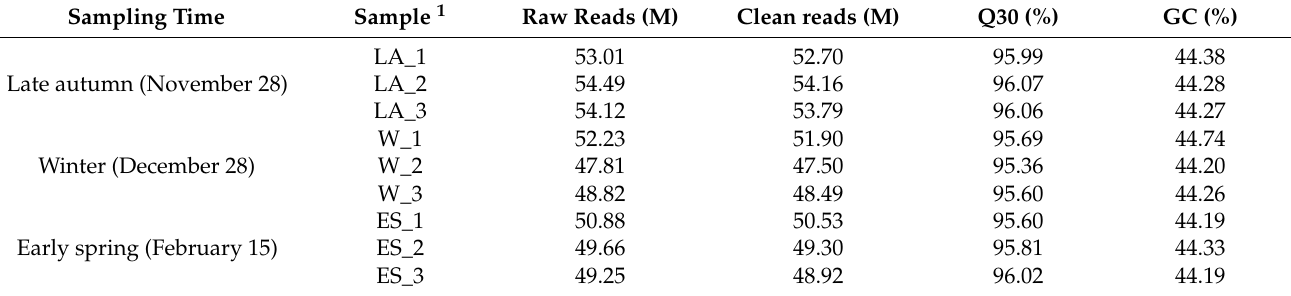
Table 1. Sequencing parameters of the Cryptomeria fortunei transcriptomes from three needle